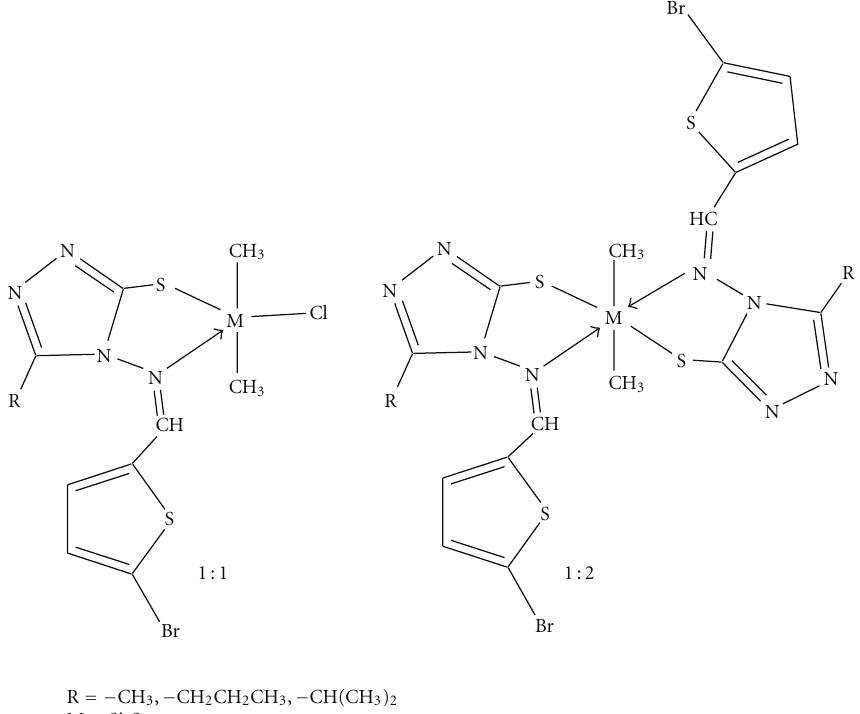
Figure 6: Proposed structures of the 1 :1 and 1:2 complexes, where 1: 1 complexes, coordination number = 5 are proposed to have trigonal bipyramidal and 1: 2 complexes, coordination number = 6 are proposed to have octahedral